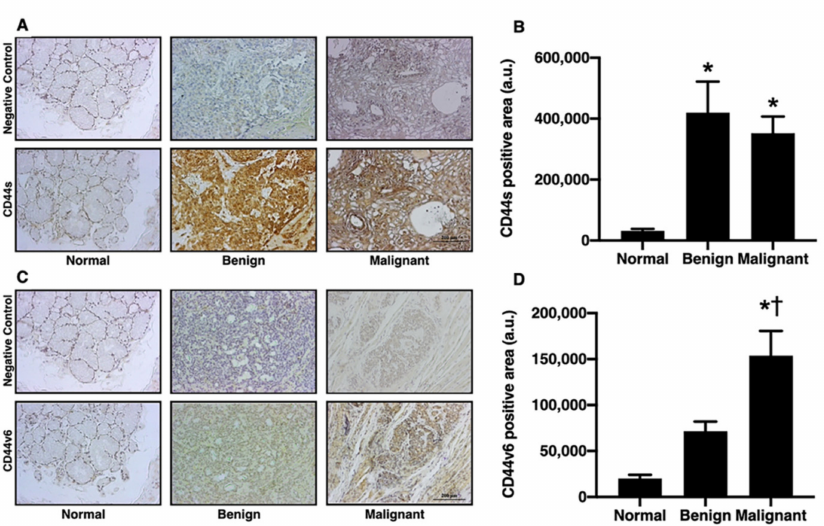
Figure 2. The CD44s and CD44v6 expression in oral salivary gland tumors. ( A ) The example images of the CD44s positive areas as indicated by IHC staining in normal, benign, and malignant groups (left to right panel, respectively) (bar = 200 µ m). ( B ) The benign group and malignant group equally increased the CD44s positive area. ( C ) The example images of CD44v6 positive areas as indicated by IHC staining in normal, benign, and malignant groups (left to right panel, respectively) (bar = 200 µ m). ( D ) CD44v6positive area increased in the benign group, while the malignant group had the highest level of CD44v6 positive area. * p < 0.05 vs. normal, † p < 0.05 vs. benign.